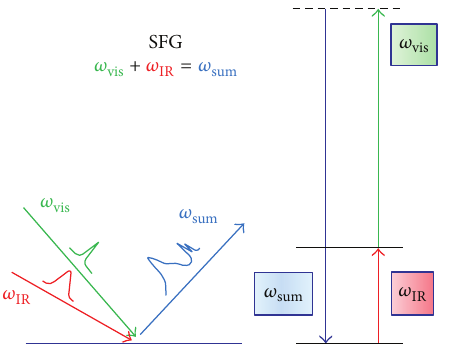
Scheme 1: The second-order optical process of sum frequency generation vibrational